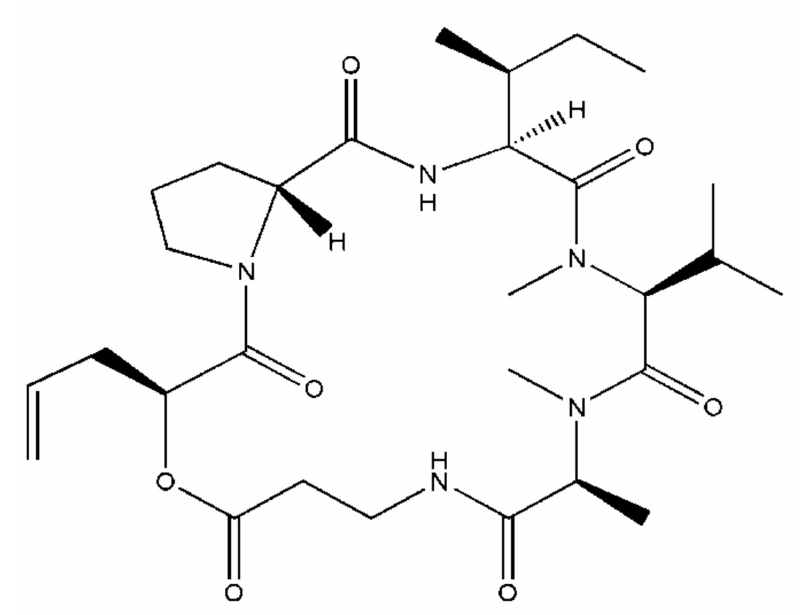
Figure 1. The structure of Destruxin